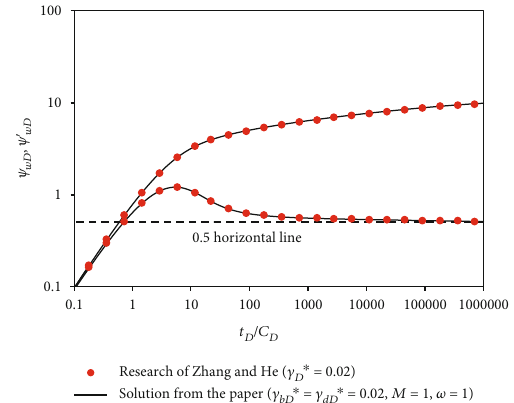
Figure 8: Well test curves of the pressure drawdown well test under di ff erent stress sensitivity coe ffi cients.